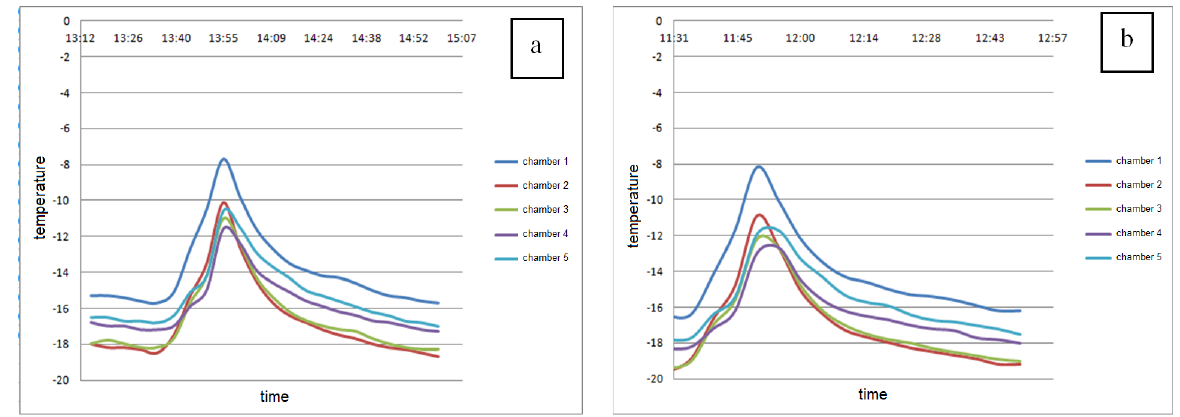
Figure 7. Temperature monitoring in the freezing module boxes during insertion of food products ( a ) or removal of food products ( b ) .